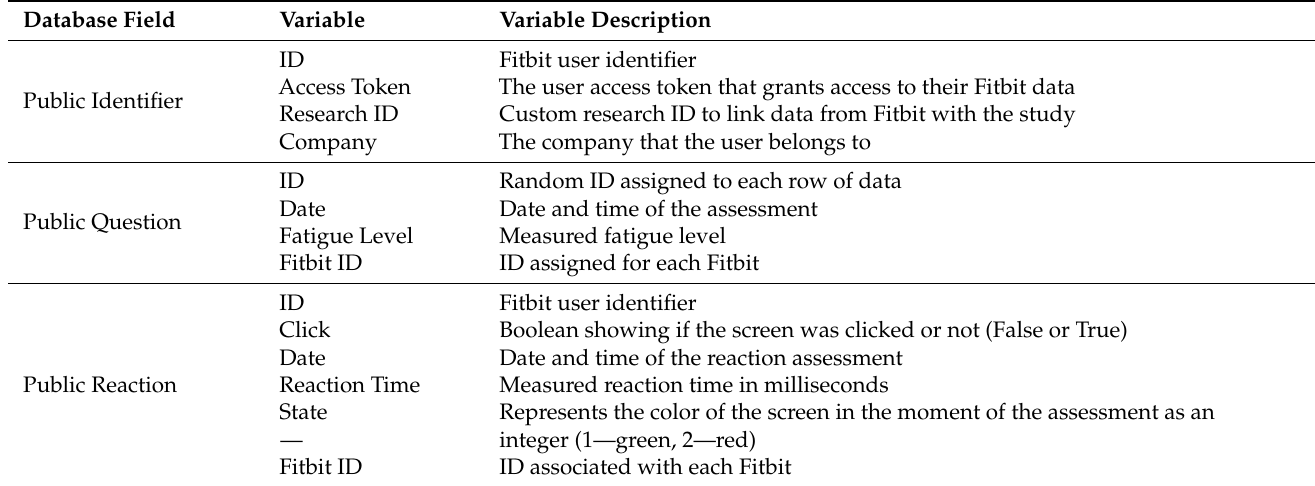
Table 4. Database fields, variables, and